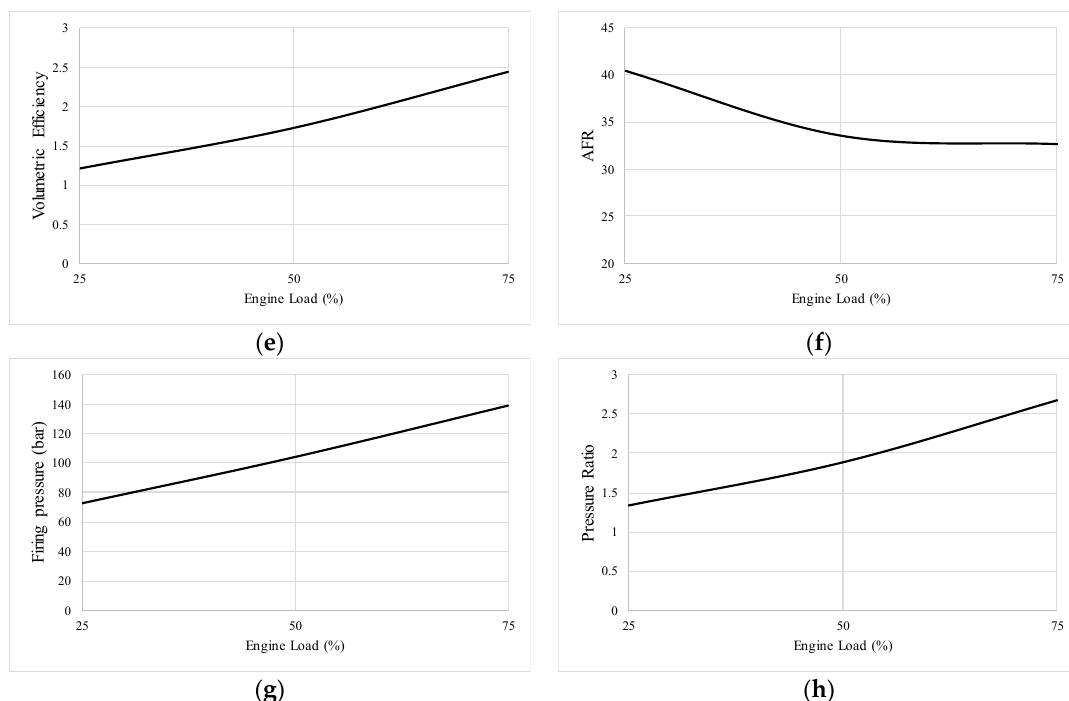
Figure 8. Variation of ( a ) ambient temperature; ( b ) BMEP; ( c ) BSFC; ( d ) thermal efficiency; ( e ) volumetric efficiency; ( f ) AFR; ( g ) firing pressure; ( h ) compressor pressure ratio for different engine loads.